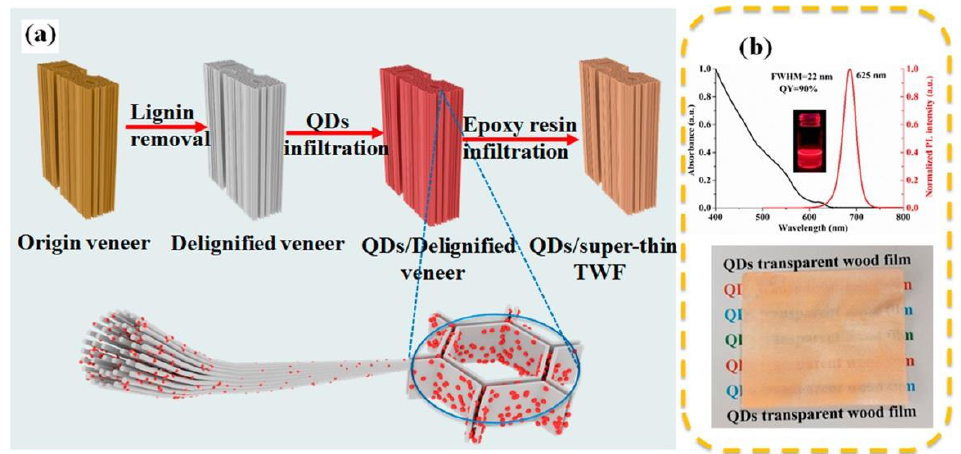
Figure 11. ( a ) Schematic illustration of preparation of QD/superthin transparent wood films (TWFs). ( b ) Luminescence and absorption spectra of the red QD solution (top) and a digital image of the QDs/delignified veneer (bottom). Reprinted with permission from [37], copyright 2022, American Chemical Society.